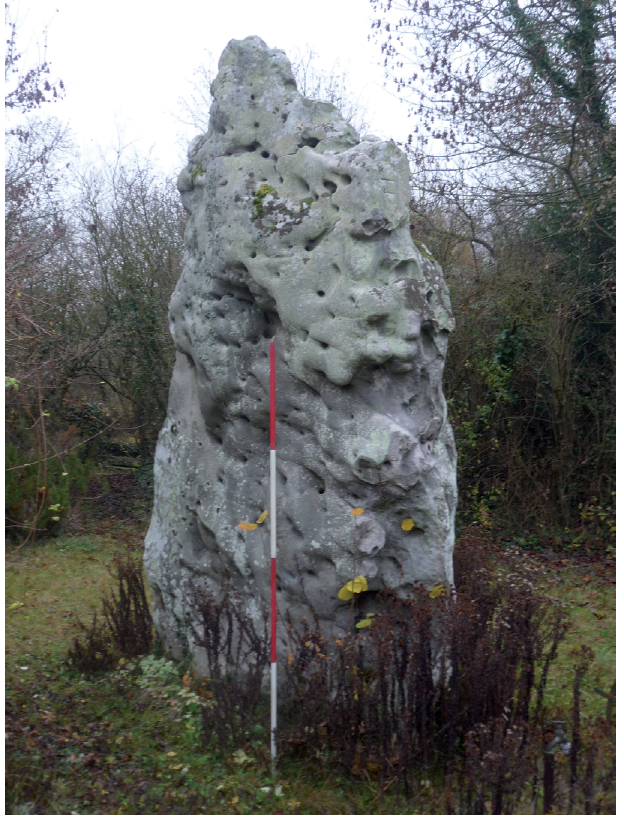
Figure 14. The Pierrefitte menhir lies on the communal limit between Étampes and St-Hilaire (Essonne). The location is also the boundary between the dioceses of Chartres and on the presumed fines between the Carnutes and the Senons. © J. Bruant/